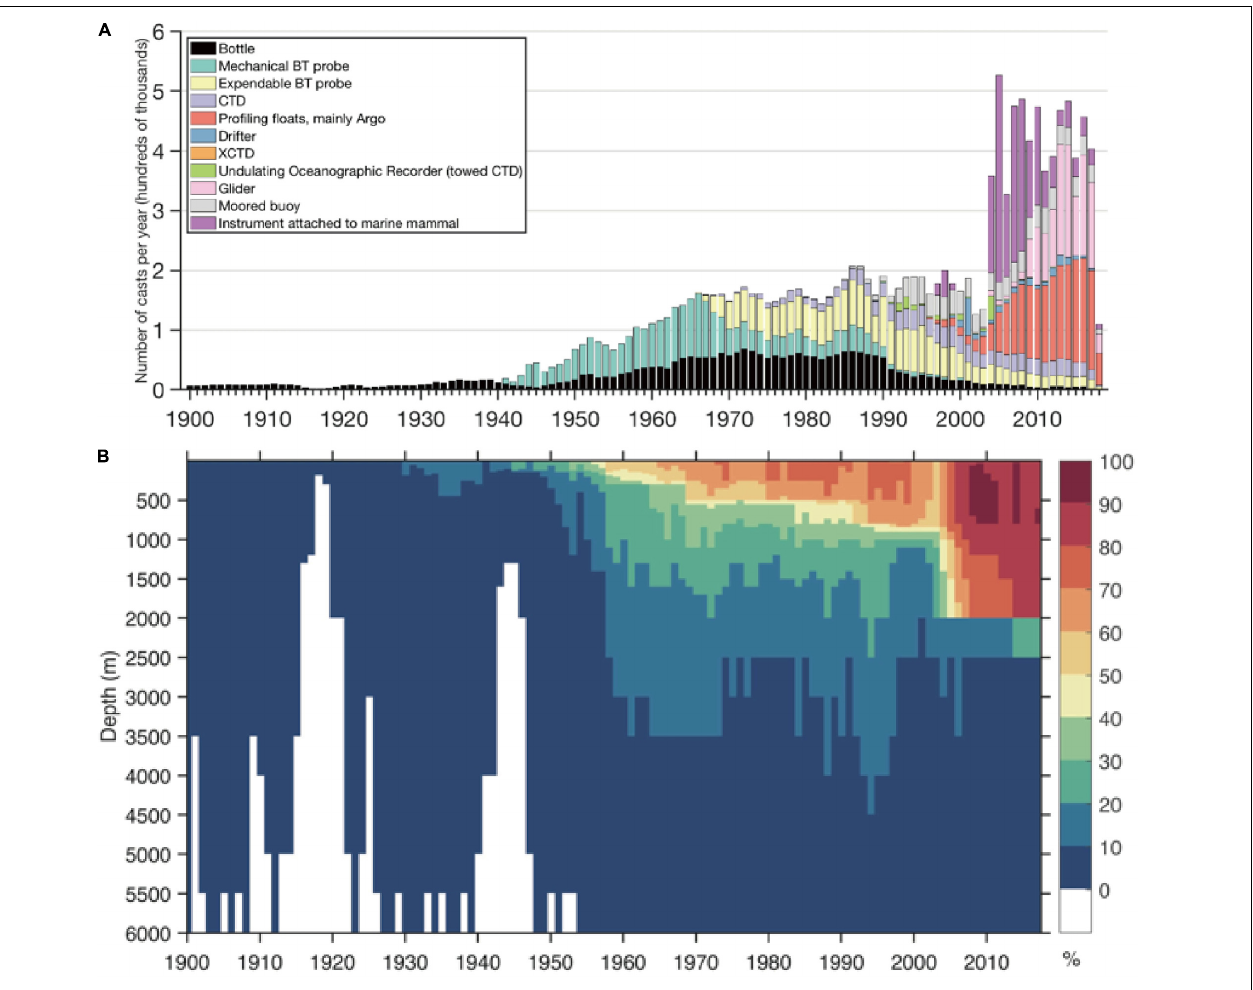
FIGURE 10 | (A) Number of subsurface ocean temperature profiles per year by instrument type 1900–2017. (BT, Bathythermograph; CTD, Conductivity-Temperature-Depth; XCTD, Expendable CTD). (B) Ocean subsurface observation coverage. Percentage (%) of data coverage for 3 × 3 boxes over the global ocean area from 5 to 6,000 m. Figure from Meyssignac et al.